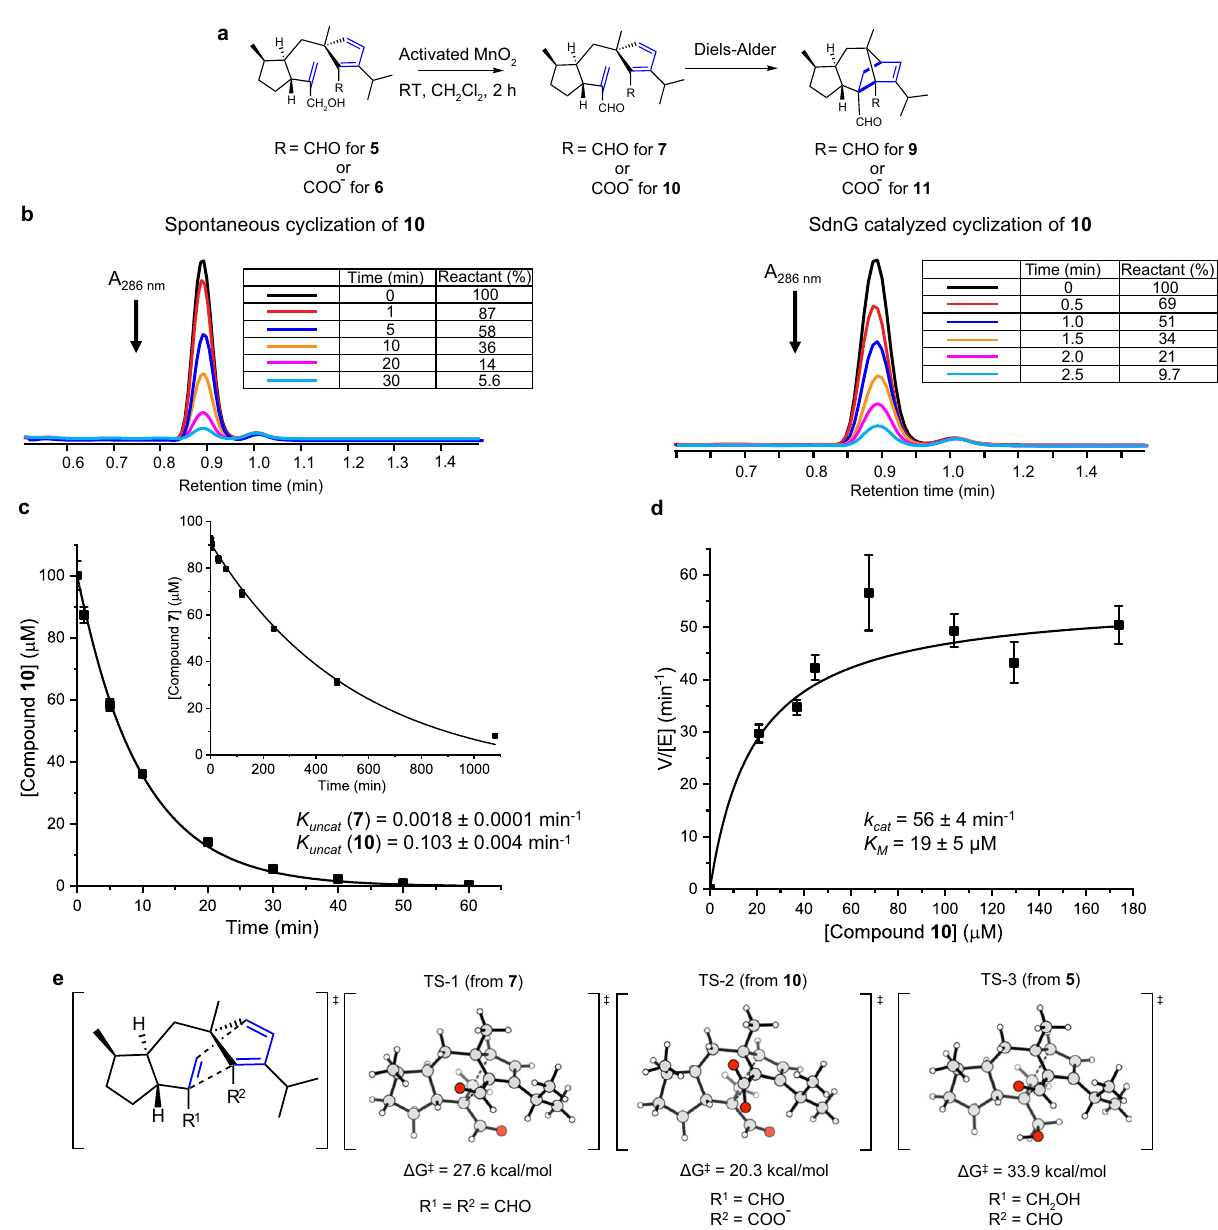
Fig. 4 In vitro characterization of non-enzymatic and enzymatic norbornene formation in sordaricin biosynthesis. a Overall synthetic scheme for compound 7 and 10 . b Cyclization of compound 10 in the absence (left) and presence (right) of SdnG in a 50mM HEPES buffer, pH 7.4. Decrease at A 286 nm (disappearance of the cyclopentadiene chromophore) was used to monitor the cyclization. c First order kinetics of non-enzymatic cyclization of compounds 10 and 7 (inset). The data points and error bars represent the mean and standard deviation of n = 3 independent measures respectively. Errors associated with the kinetic parameters were obtained from fi tting. Source data are provided as a Source Data fi le. d Michalis-Menten kinetics of SdnG with compound 10 as substrate. The data points and error bars represent the mean and standard deviation of n = 3 independent measures respectively. Errors associated with the kinetic parameters were obtained from fi tting. Source data are provided as a Source Data fi le. e DFT calculations of IMDA transition states in water for dialdehyde 7 (TS-1), and carboxylate-aldehyde 10 (TS-2), and aldehyde-alcohol 5